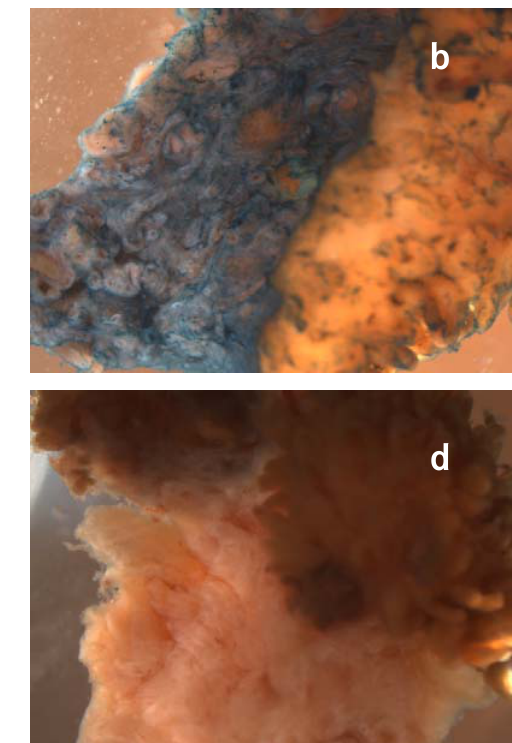
Figure 3. Macrophotographs (at 10x magnification) of tissue samples exposed to 60 μ g of uncomplexed ABG (a), to a complex of 60 μ g ABG with 5 μ M bTP (b) and to a complex of 5 μ g ABG with 5 μ M bTP (c) in the experiment abbreviated as “SCCC_1” (see Table 1 for details). The tissue samples were from the specimen diagnosed with stage IVB squamous cell carcinoma of the cervix (SCCC). The cervical stromal parts of samples are directed to the left (a, b, c) or down (d). The image of the negative control (“no drug”) is